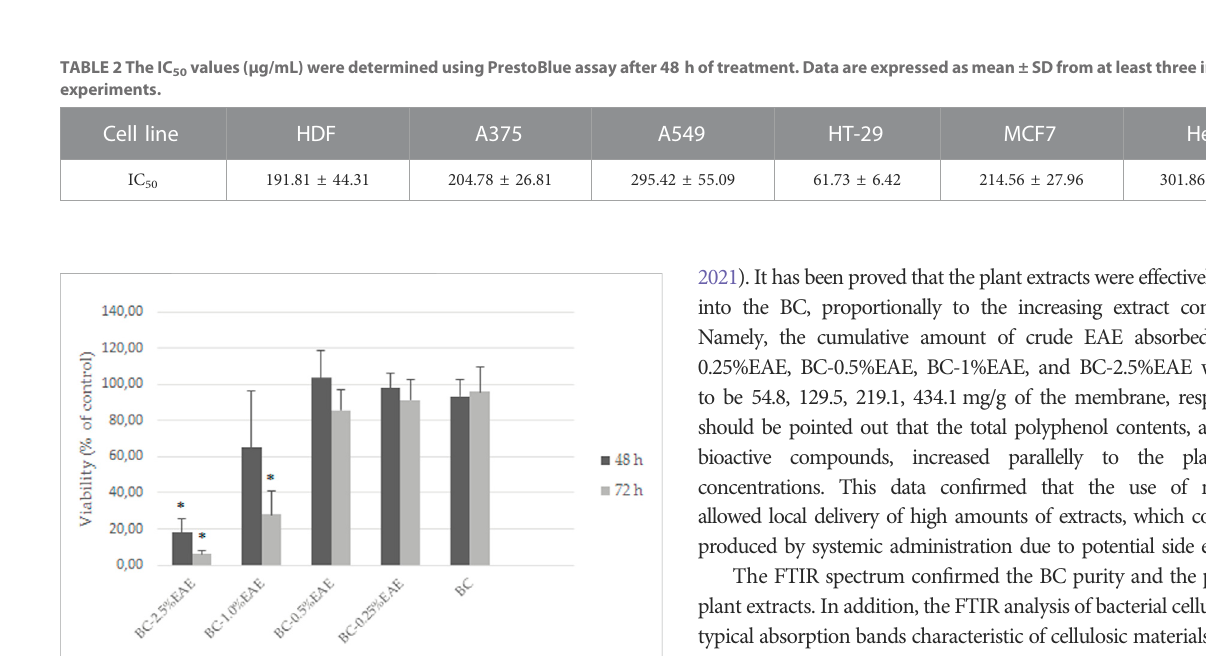
FIGURE 8 TheviabilityofHT-29cellsafterexposuretoBC-EAEfor48 hand 72 h; * p < 0.05, statistical signi fi cance compared with BC (Student ’ s t-test).